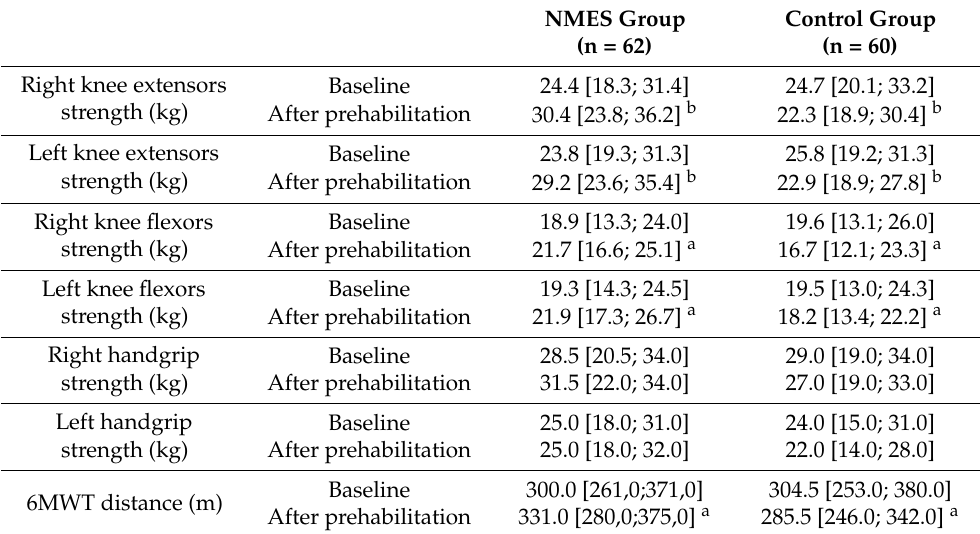
group, in contrast to the control group. Accordingly, KES in the second test was significantly higher in the NMES group than in the control ( p < 0.001 on the right and the left legs).